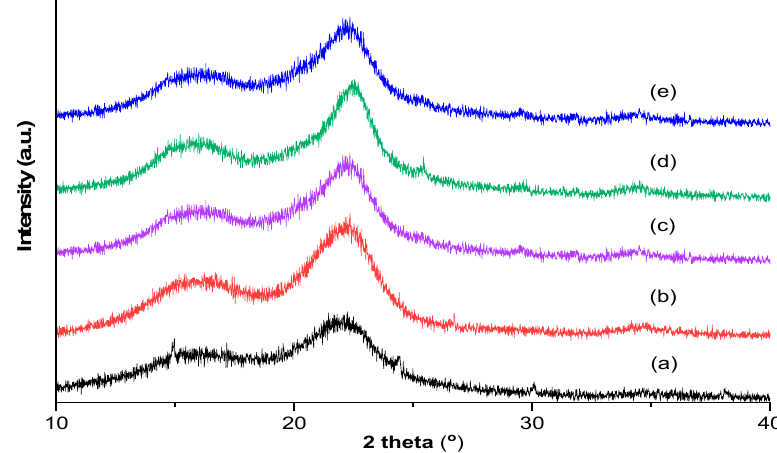
Figure 7. XRD patterns of the vine-shoot waste (Busuioaca de Bohotin variety) samples: ( a ) untreated, ( b ) delignified, ( c ) autohydrolysed at 150 ◦ C, ( d ) autohydrolysed at 165 ◦ C and ( e ) autohydrolysed at 180 ◦ C.